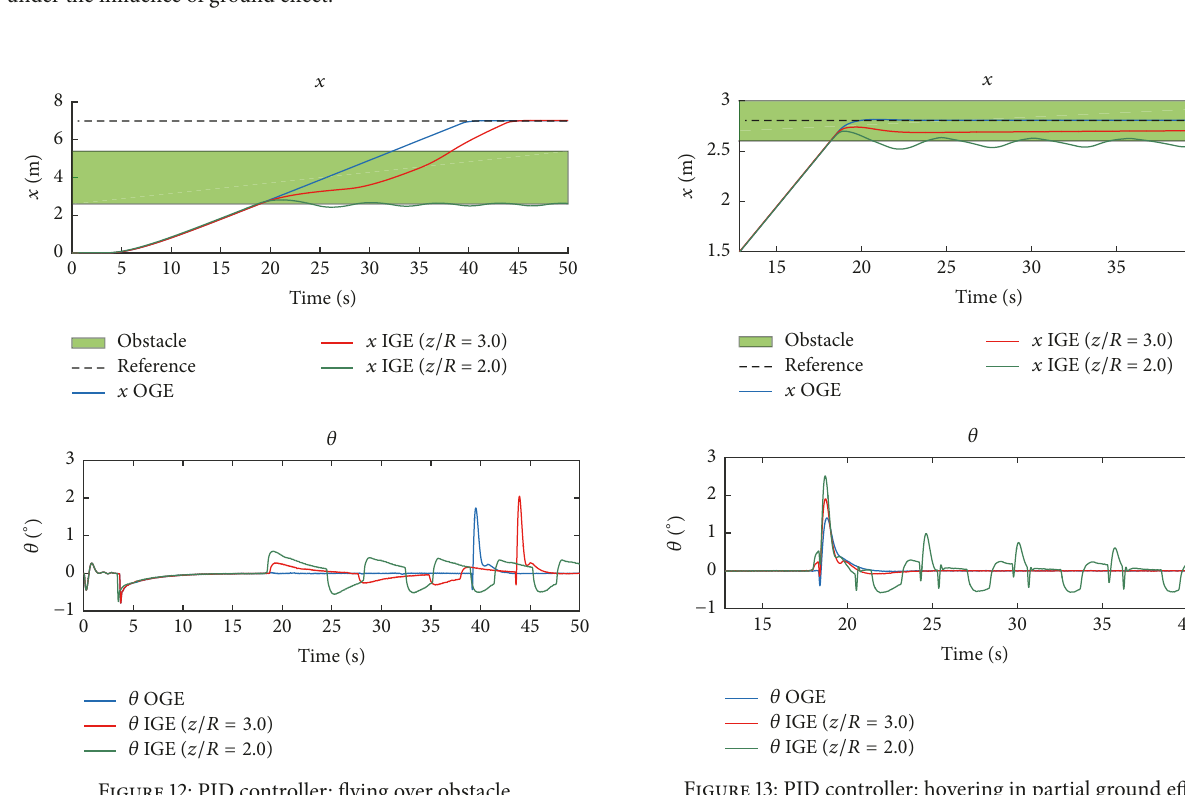
pushed away from the obstacle when 𝑧/𝑅 = 3.0 , and it is able to arrive to its destination at point B ( 𝑥 = 7 ) when it is flying closer to the obstacle at 𝑧/𝑅 = 2.0 .